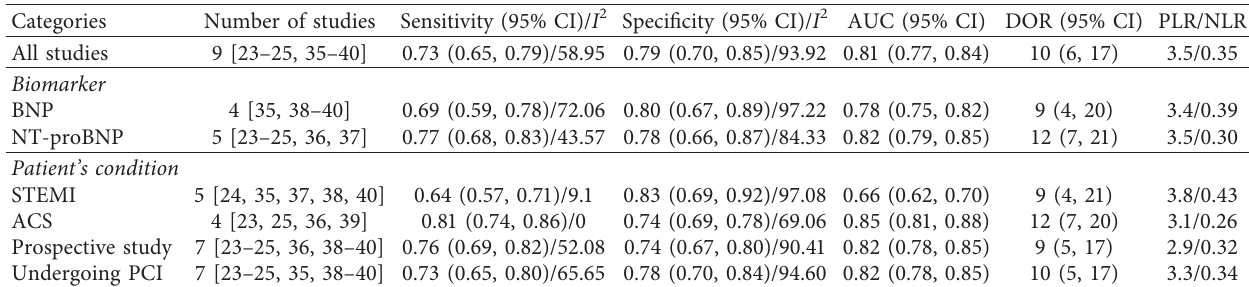
Figure 5: Fagan nomogram of brain natriuretic peptide for the diagnosis of contrast-induced acute kidney injury in patients with acute coronary syndrome undergoing coronary angiography. The pretest probability was set to 50%. The use of brain natriuretic peptide for the detection of contrast-induced acute kidney injury increased the posttest probability to 78% when the brain natriuretic peptide results were positive; the posttest probability decreased to 26% when the brain natriuretic peptide results were negative. Table 3: Results of sensitivity analysis and subgroup